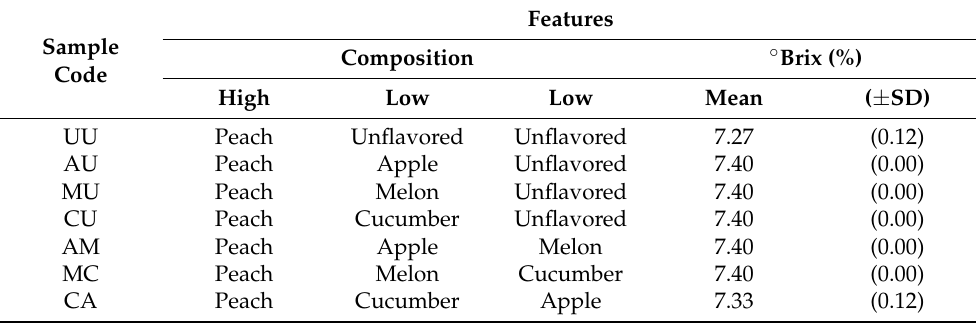
Table 1. Information on the seven flavored black teas used for intensity rating of sensory